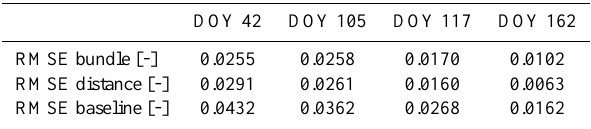
Table 3. RMSE values when comparing to the truth calculated on a seven days time window starting at the assimilation time steps. The optimisation in the assimilated runs was performed w.r.t. the information present in the bundle (bundle) or w.r.t. the Wasserstein distance between the empirical and the central cumulative normal distribution in the bundle (distance).